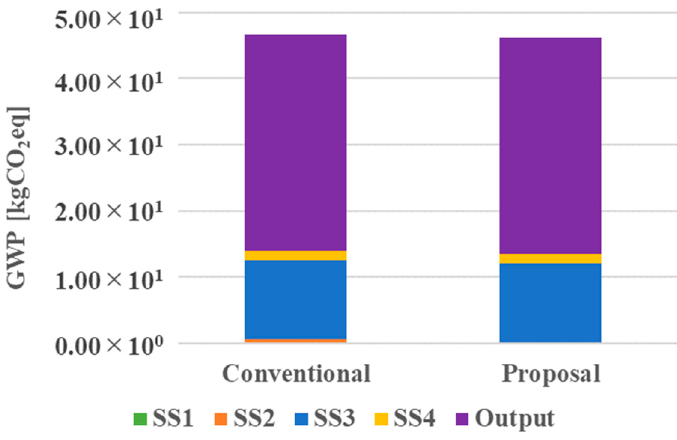
Figure 8. Results of GWP in conventional and proposed cases.